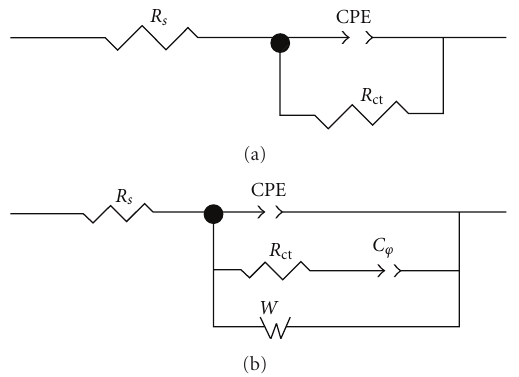
Figure 5: Equivalent circuits used for approximation of the EIS data: (a) the bare GC and (b) GC/RuOHCF/RuHCF electrodes in the presence of DA (external probe). Warburg element considers the possible contribution of DA in the solution phase at very low frequency. The double-layer capacitance is replaced by constant phase element CPE.